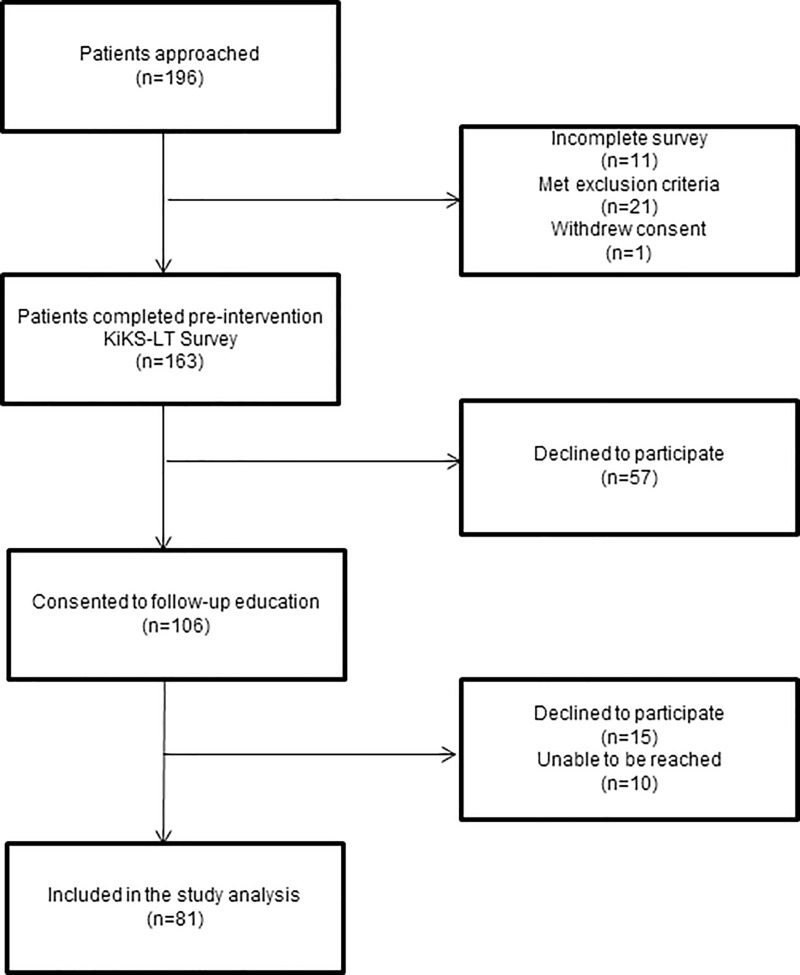
Consort diagram: Cohort determination.